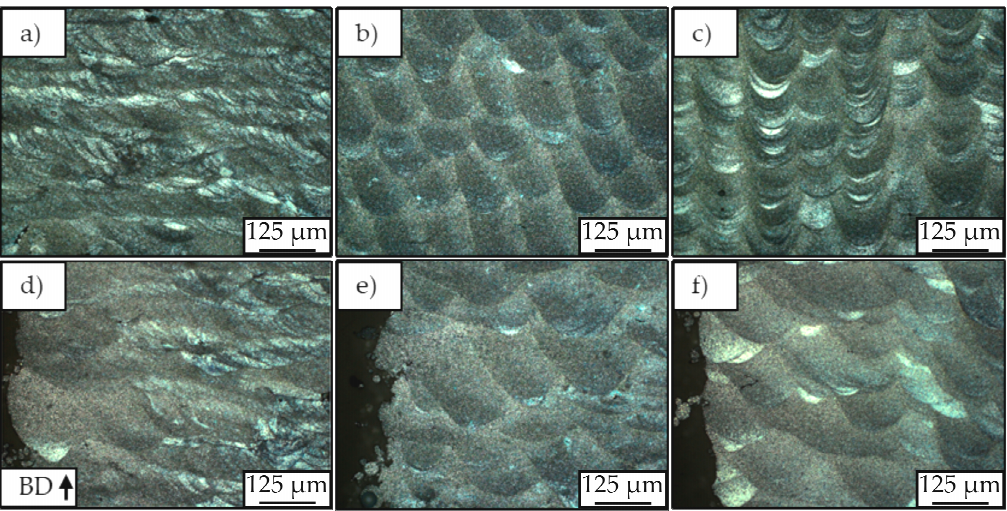
Figure 10. Light microscopy pictures of center ( a , b , c ) and surface ( d , e , f ) of samples in batch A Mg ( a , d ), B Mg ( b , e ) and C Mg ( c , f ). Etchant: Nital 2%.